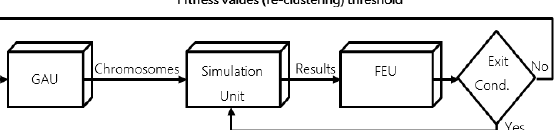
Figure 6. GA-based membership function optimizer for